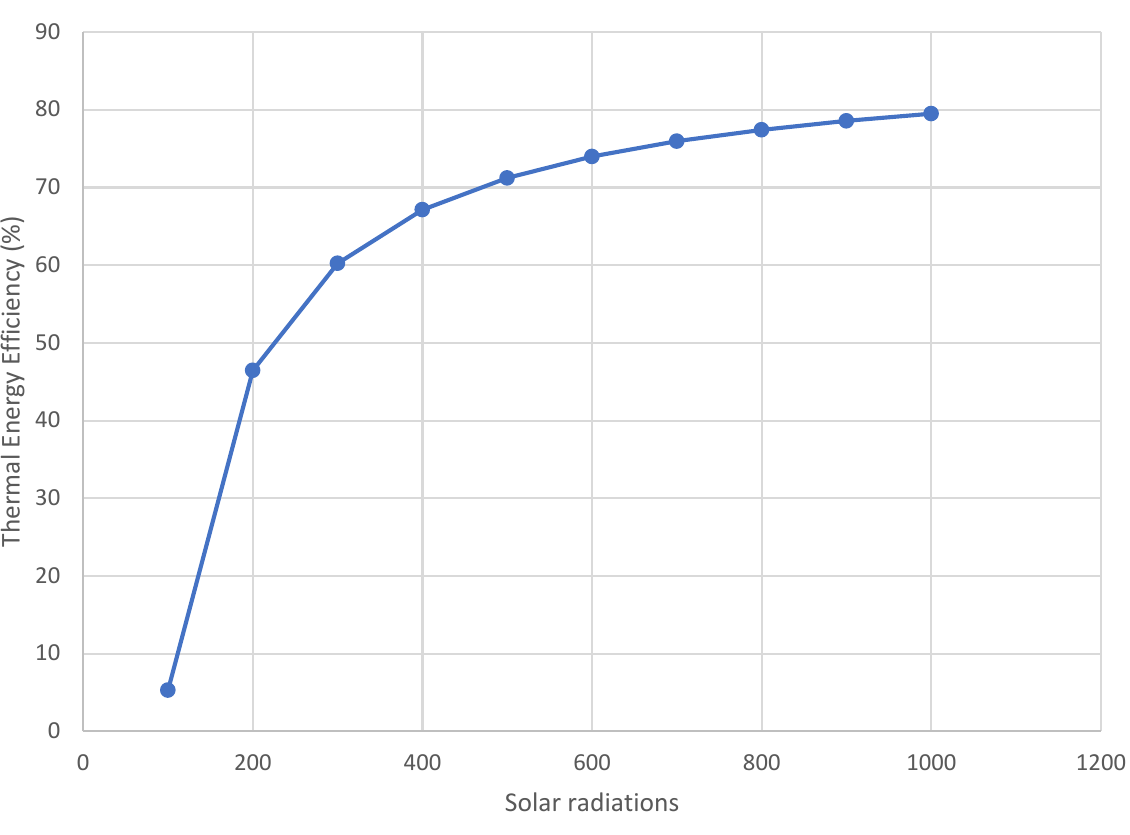
Figure 6. Energy efficiency response of FPC.